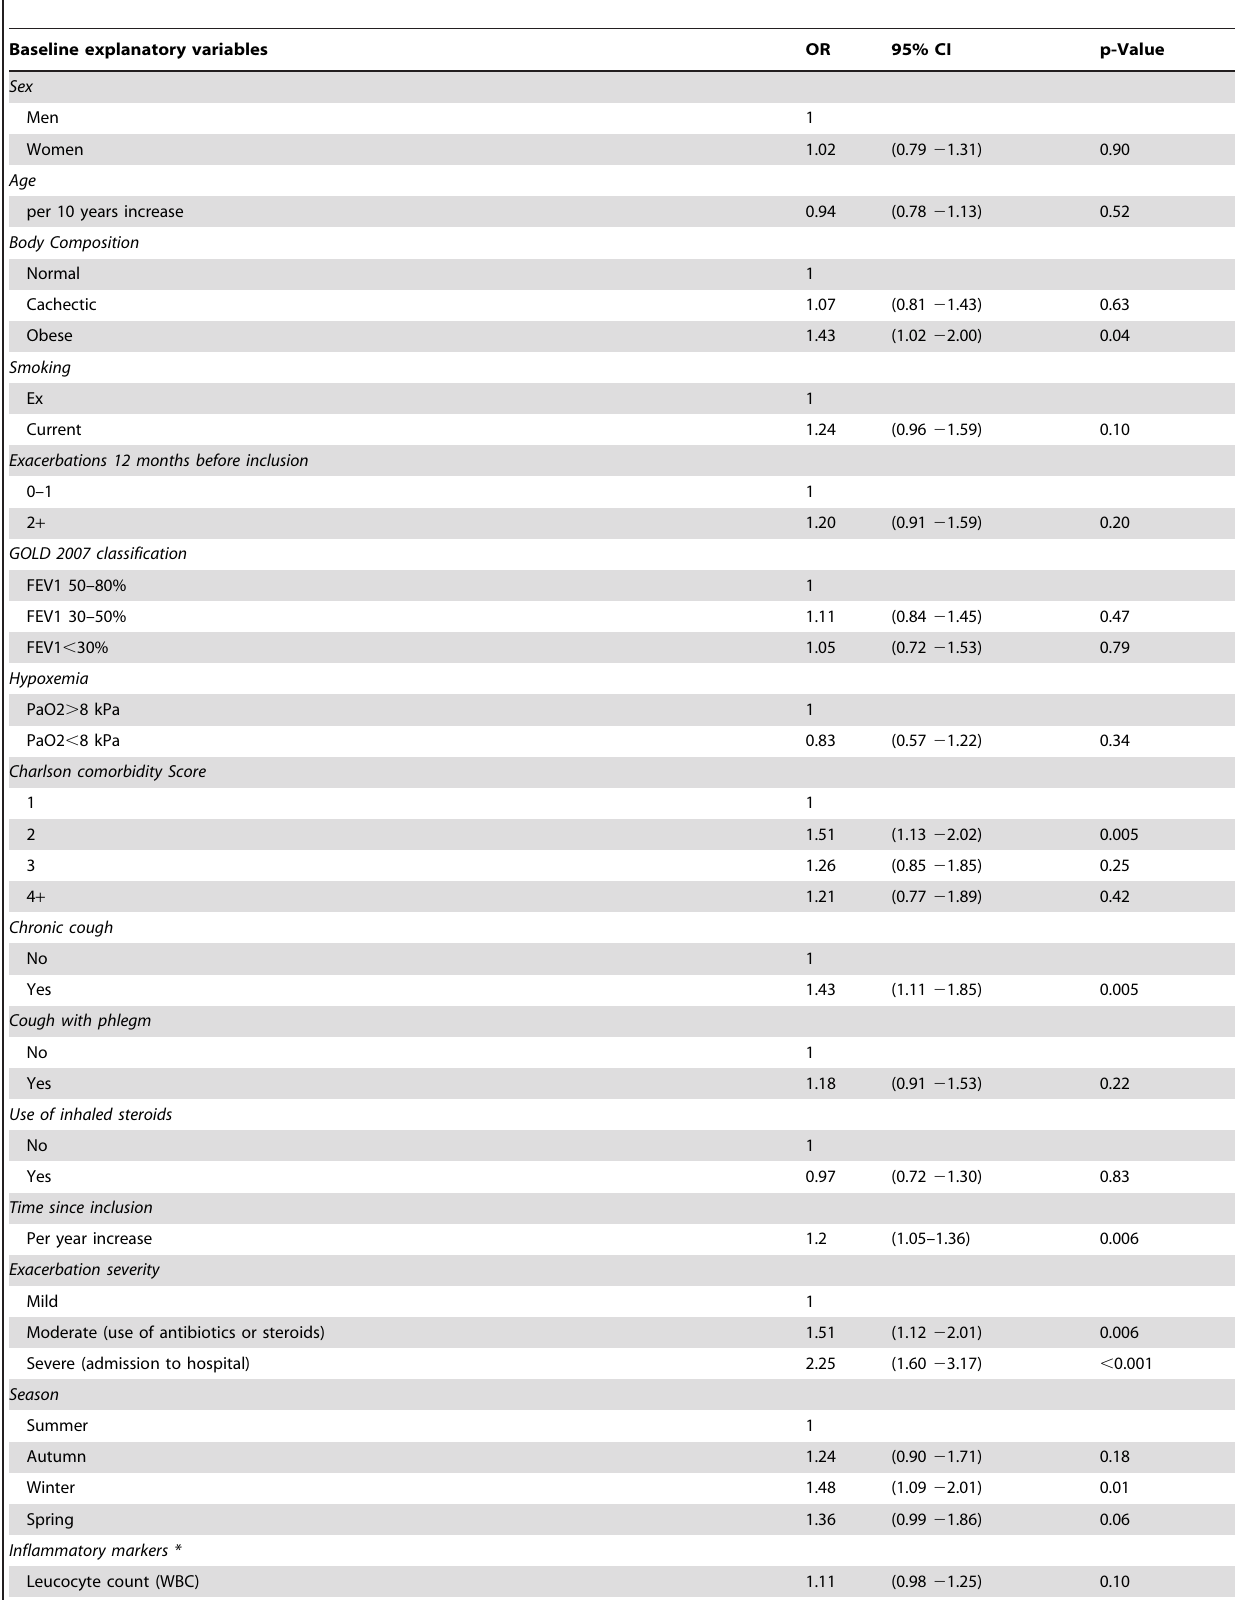
Table 4. Bivariate predictors of copd-exacerbation duration more than three weeks, estimated by a generalized estimation equation logistic regression